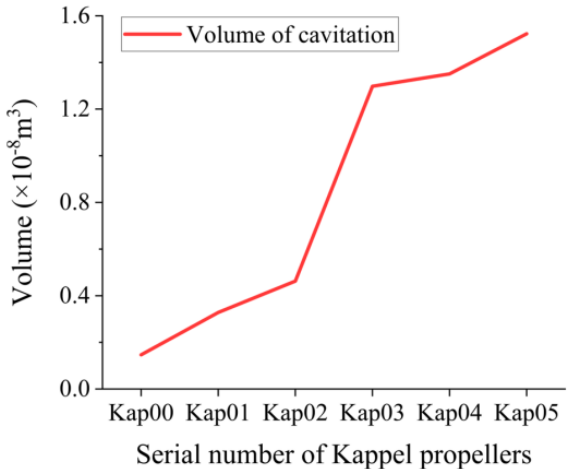
Figure 19. Cavitation volume of Kappel propellers ( J = 0.5, 30 rps, and σ =